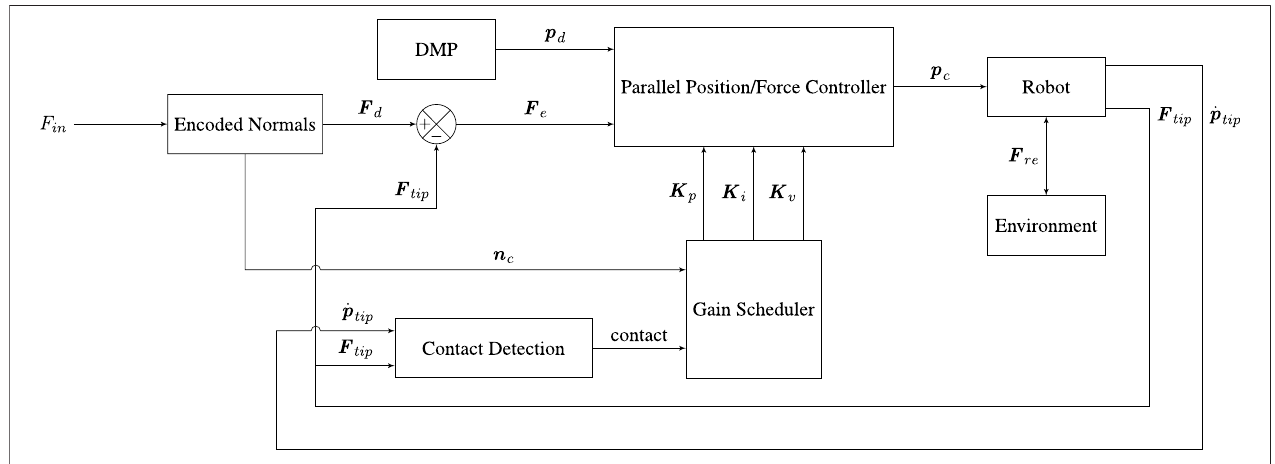
FIGURE 5 | Block diagram of the controller architecture used for task